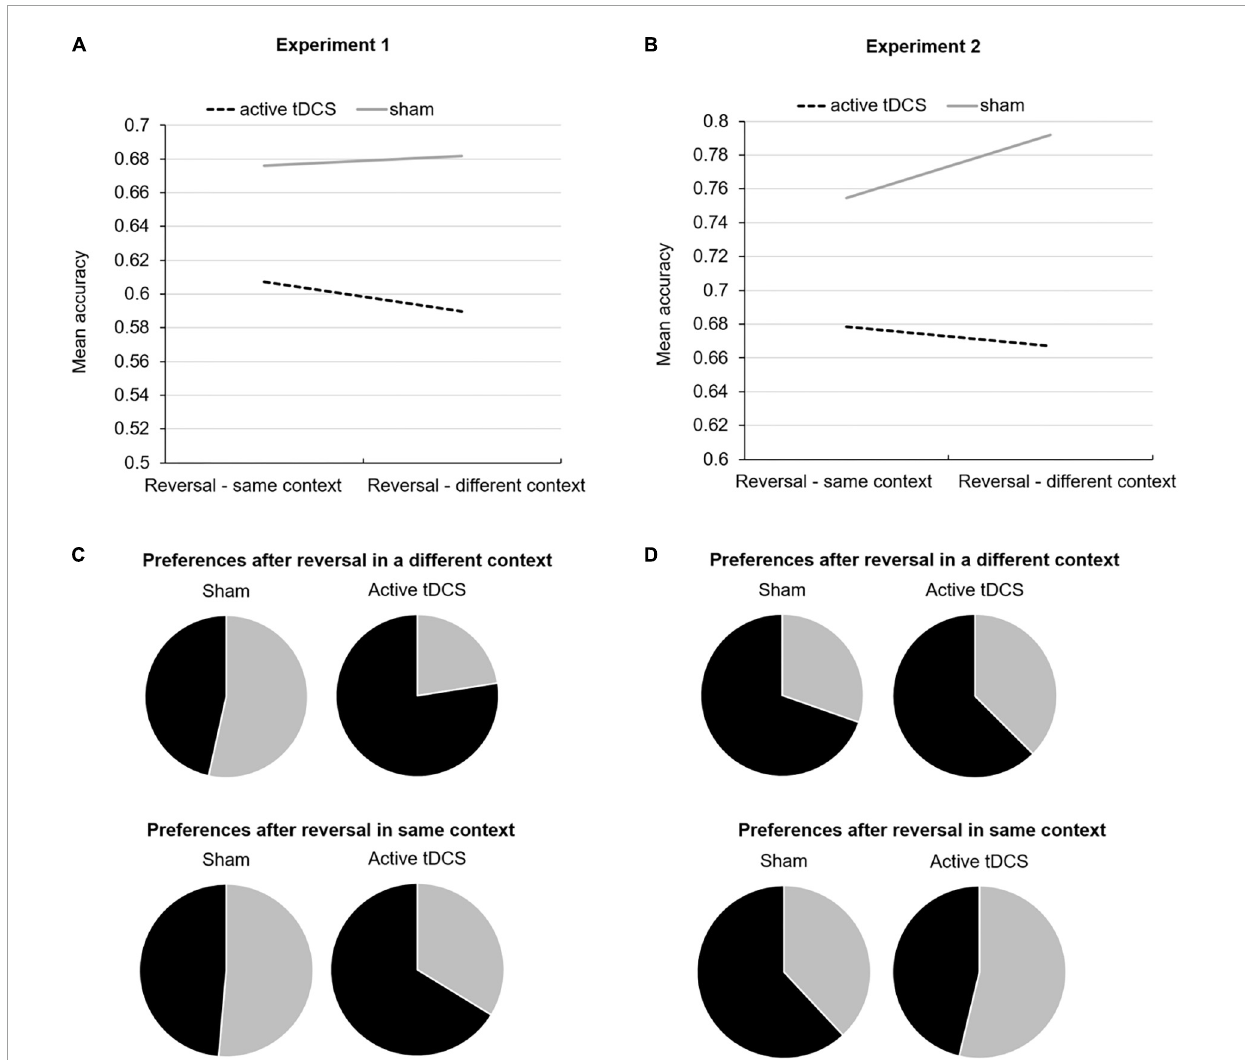
FIGURE3 Mean accuracy during reversal learning in the same and different context from initial learning for both active and sham tDCS groups for Experiment 1 (A) and Experiment 2 (B) . Pie charts reflecting choice preferences in novel Context 4 for stimuli that were initially associated with a loss but reversed to no loss (in black) versus stimuli that were initially associated with no loss but then reversed to loss (in gray) after reversal occurred in a different context and same context from initial learning for Experiment 1 (C) and Experiment 2 (D)